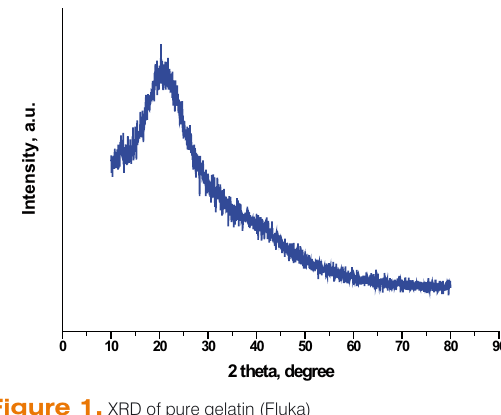
Figure 1. XRD of pure gelatin (Fluka)